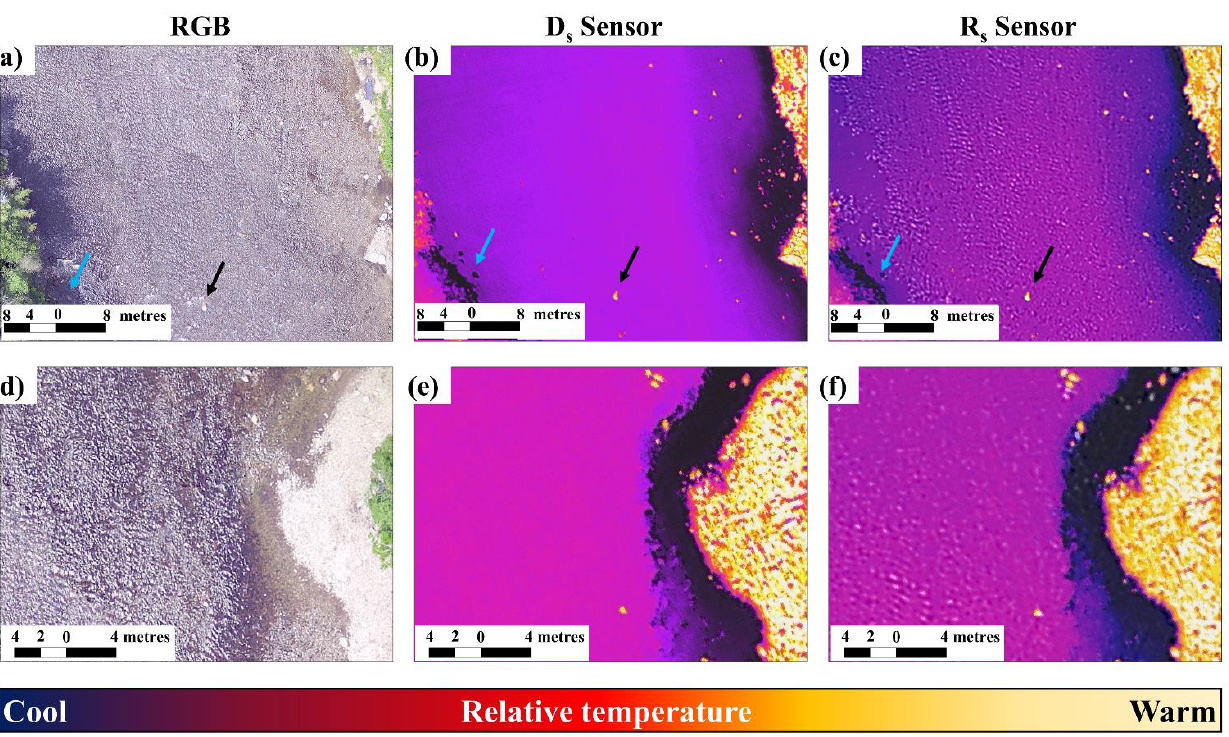
Figure 7. Qualitatively each sensor (default matte black (D s ) and aluminum shielded (R s )) detected almost identical patterns of thermal variability. This is evident via the identification of cool boulders located in the shadows (blue arrows), and warm boulders (black arrows) in the open ( a – c ), and the similarity of the thermal plume extent ( d – f ). However, the D s sensor does not detect ripples ( b , c ), while the R s sensor does ( e , f ).